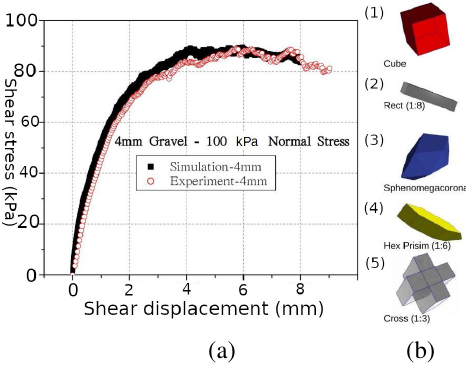
Figure 4. (a) Simulation and experimental [10] stress-strain curve for 4mm sand and (b) particle shapes used for simulations in section 4 ( P conf 100 kPa).